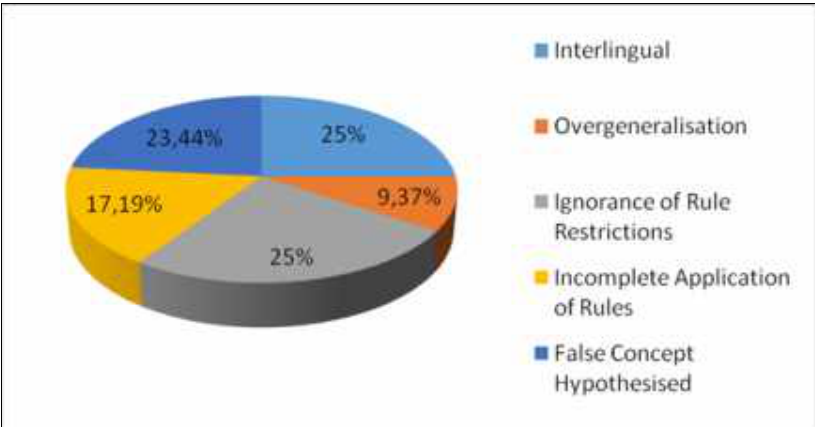
Figure 2: The Distribution of Sources of